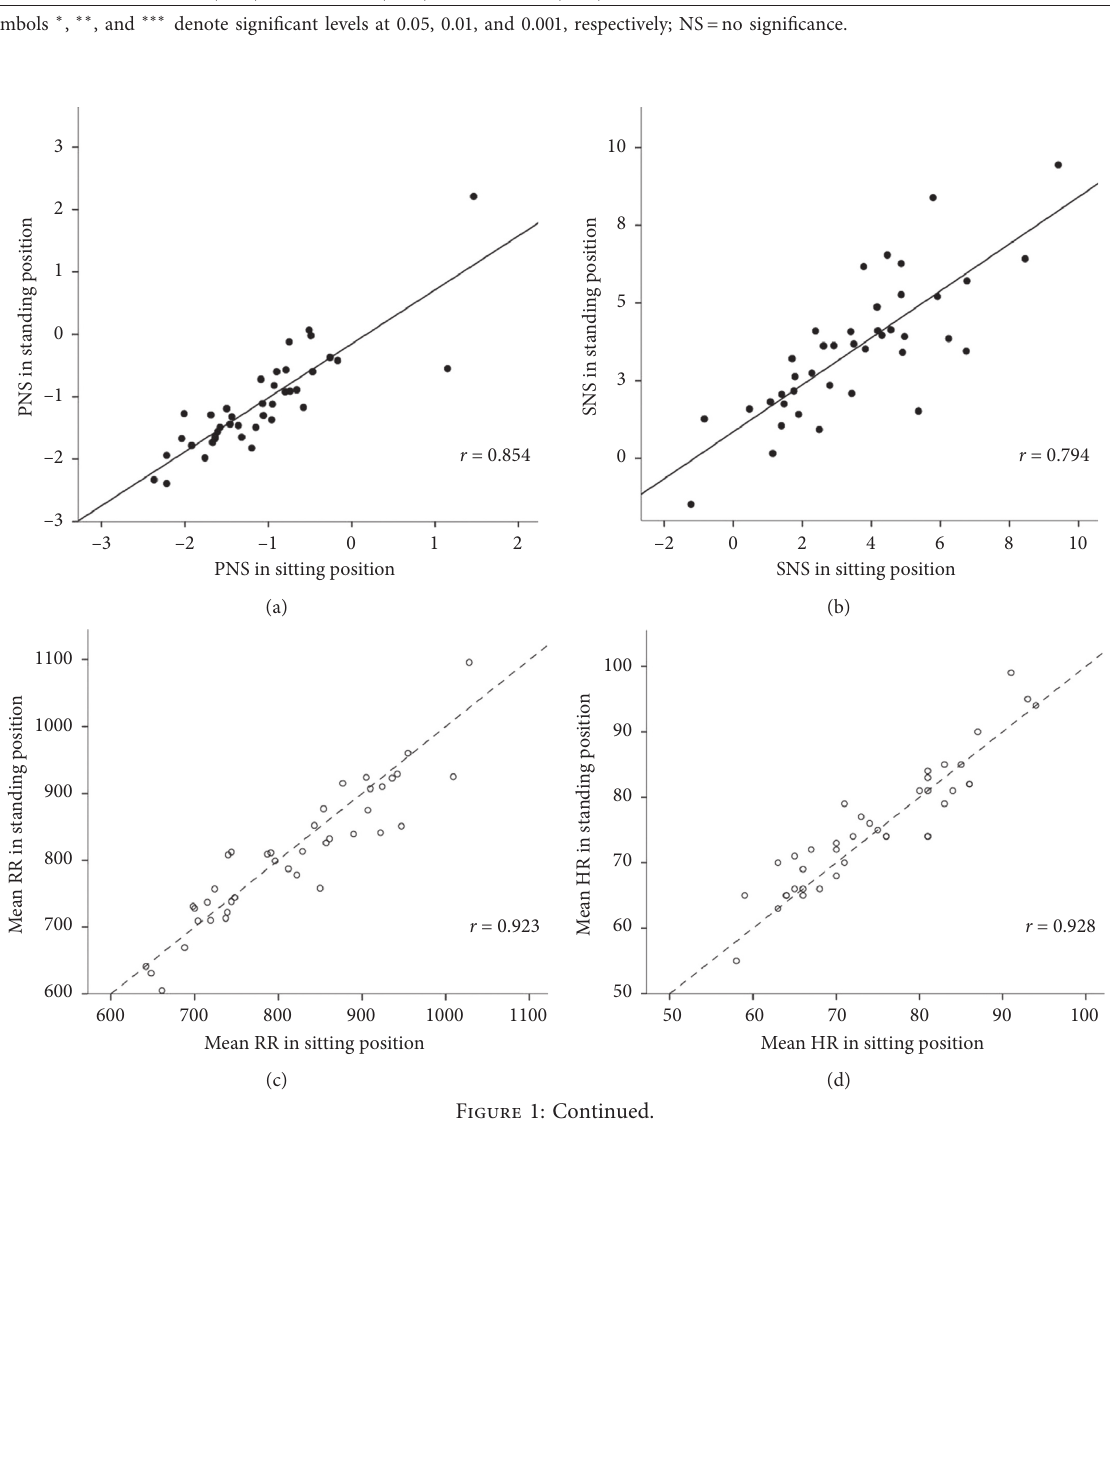
Table 4: Descriptive statistics, repeated measures ANOVA, and paired t -test for HRV markers in the frequency domain. HRV markers in frequency domain LF/HF